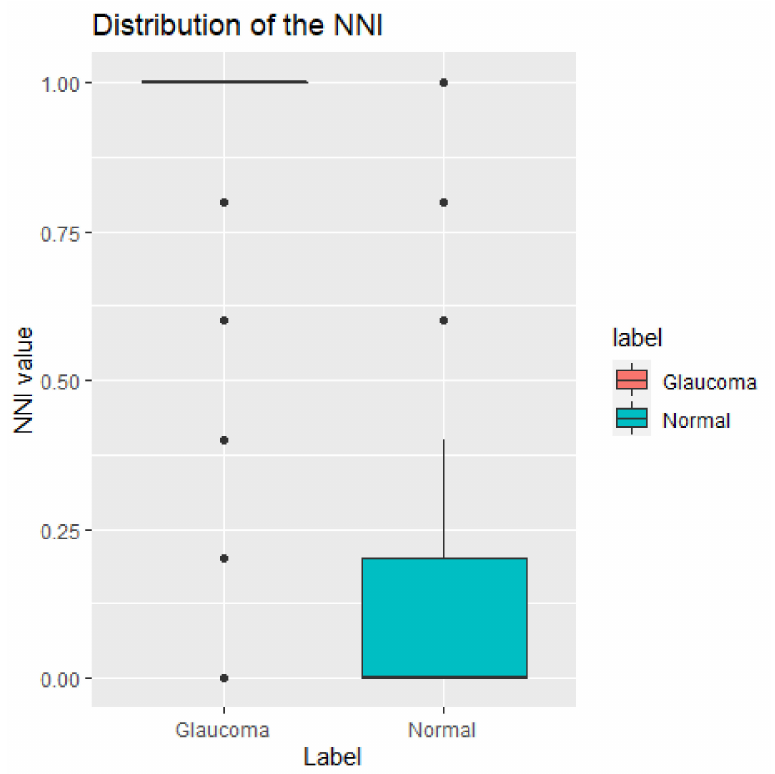
Figure 3. Distribution of the NNI